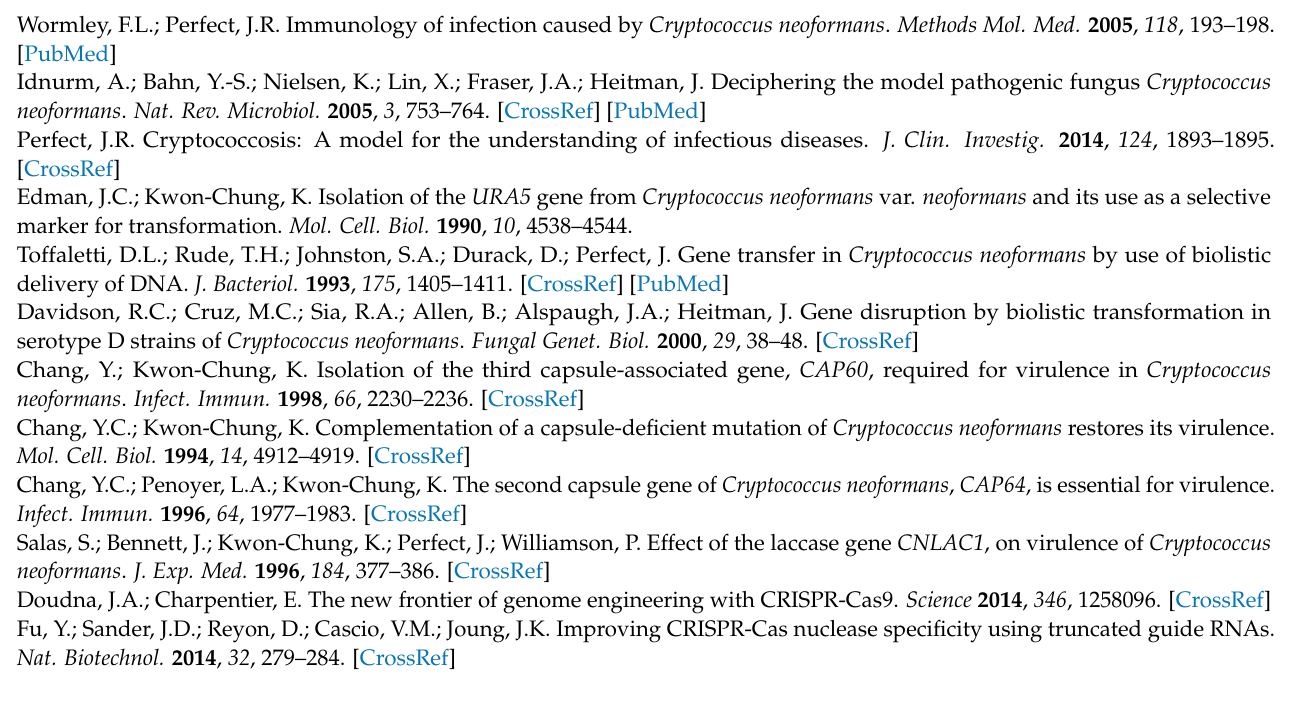
results of Figure 4B, Figure S4: full-length blot results of Figure 4C, Figure S5: full-length gel results of Figure 5B, Figure S6: full-length blot results of Figure 5C, Figure S7: full-length gel